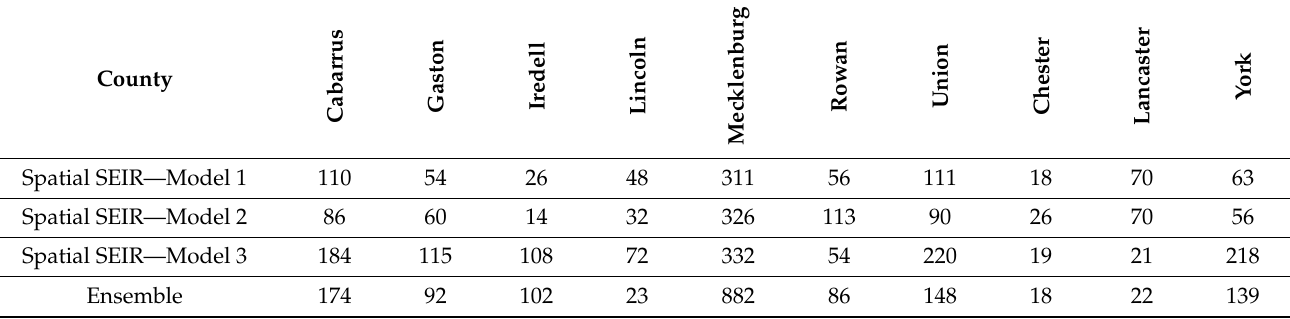
Table 4. Four-week ahead prediction RMSE values of the three variants of the spatial SEIR model and of the ensemble model for each